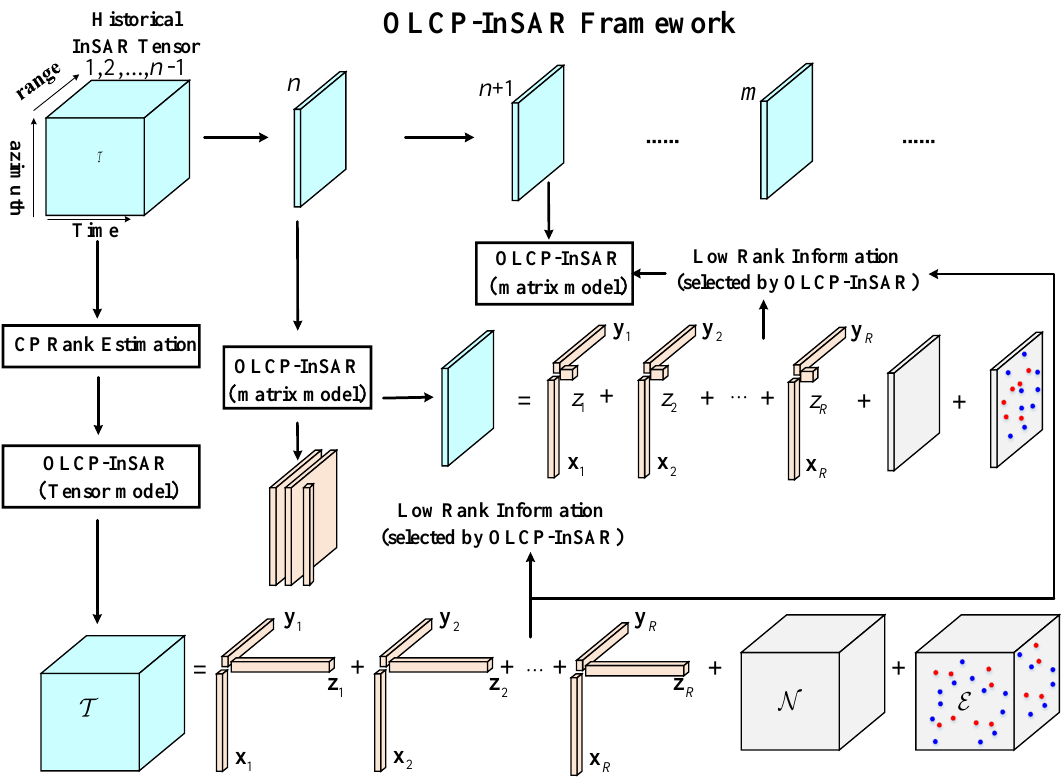
Figure 5. The filtering framework for the dynamic InSAR